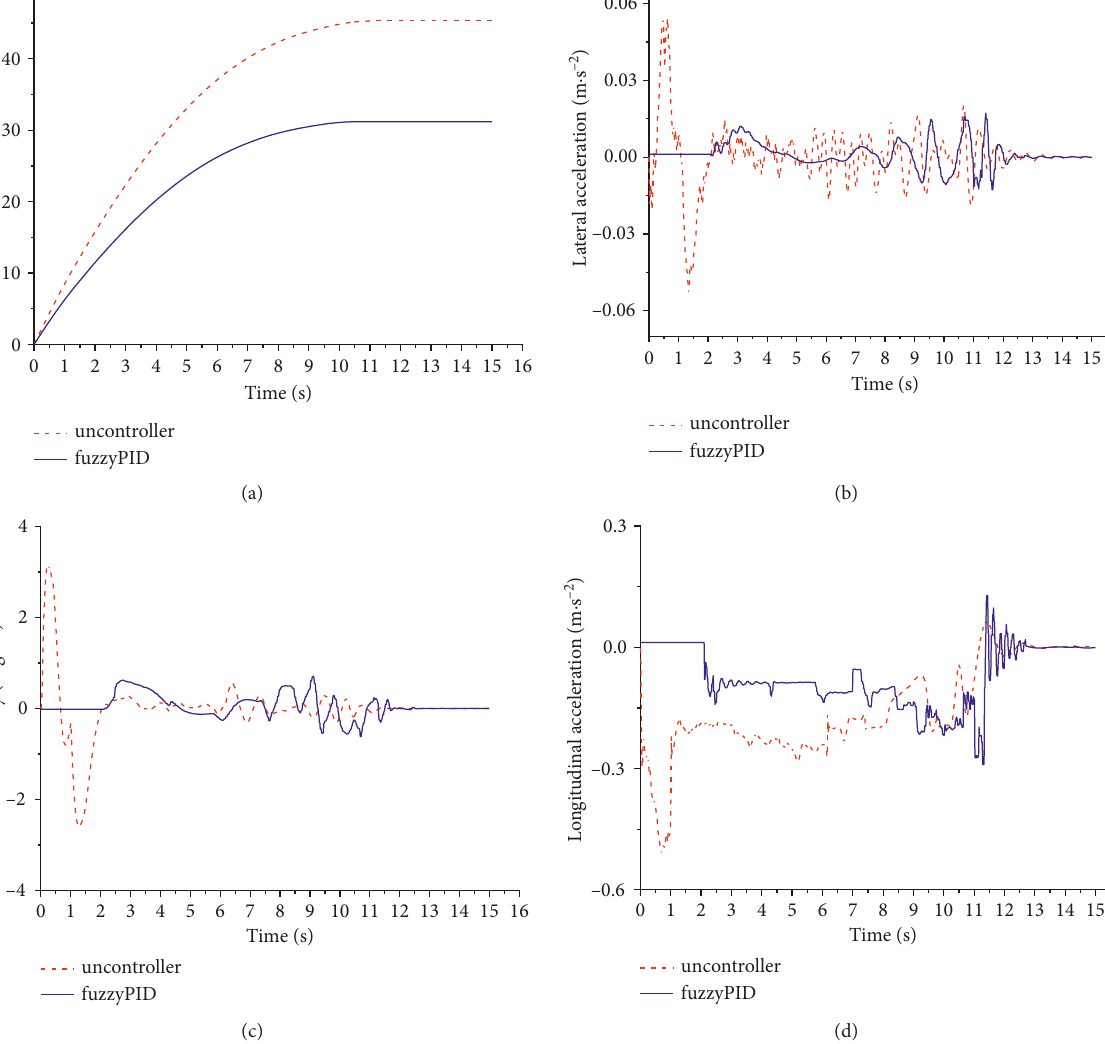
Figure 30: HIL test diagram under long downhill condition when u � 0.8. (a) Braking distance. (b) Lateral acceleration. (c) Yaw velocity. (d) Longitudinal